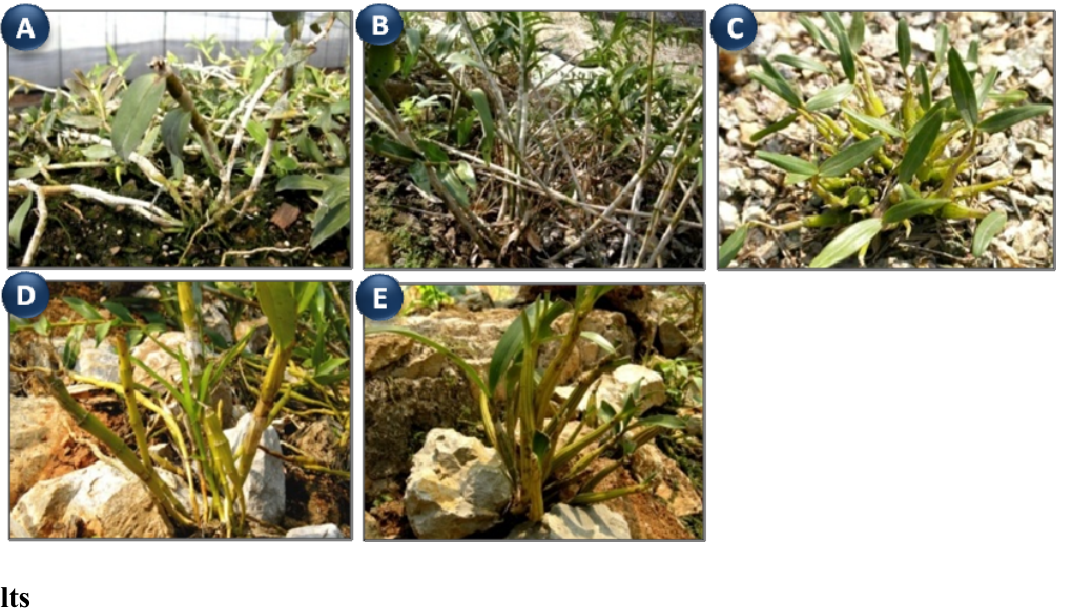
Figure 1. The plants of ( A ) Dendrobium officinale , ( B ) D. fimbriatum , ( C ) D. huoshanense , ( D ) D. nobile and ( E ) D. chrysotoxum